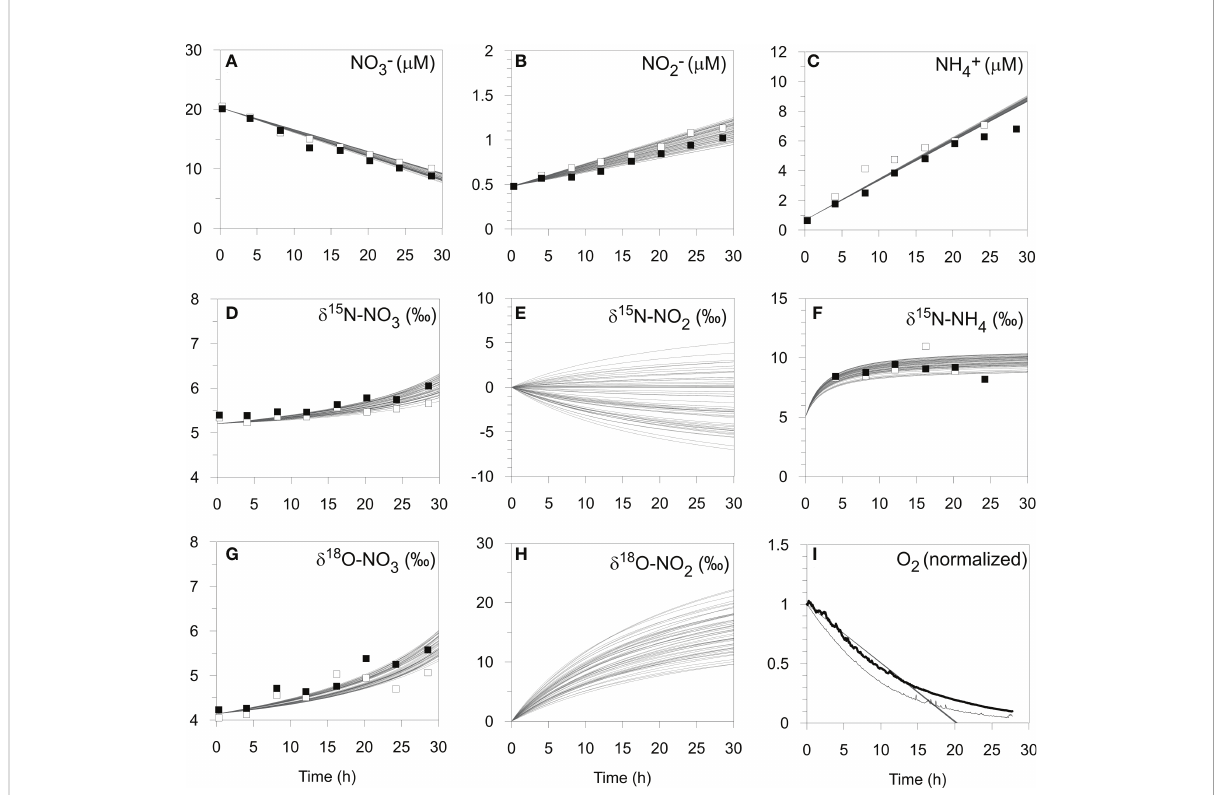
FIGURE 4 Model simulation results (curves, n = 54) of the benthic chamber incubation experiment at St. 2 on the shelf (BIGO 2-5) including (A – C) N concentrations, (D – H) N and O isotopes, and (I) O 2 concentrations (see text). Open and fi lled symbols correspond to chamber 1 and 2, respectively. For the O 2 optode data, chamber 1 and 2 are denoted by the thin and thick black lines, respectively, and have been normalized to the initial values.